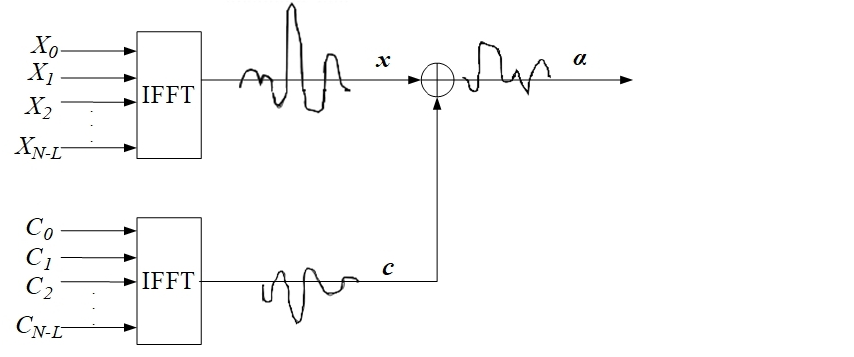
Figure 1. The structure of the conventional TR